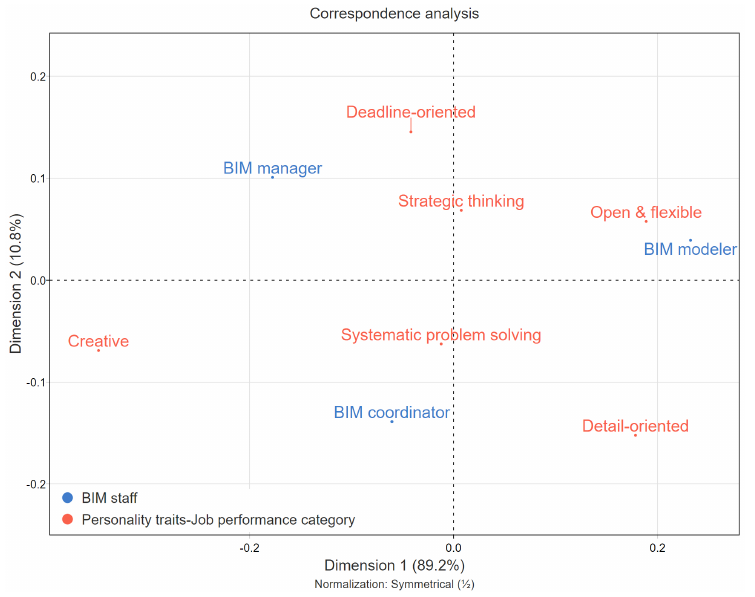
Figure 4. Comparison of the importance degree of personality traits (job performance category) between BIM staff roles—Correspondence analysis. Table 6. The required level of personality traits, in relation with role and responsibilities, ranked by BIM